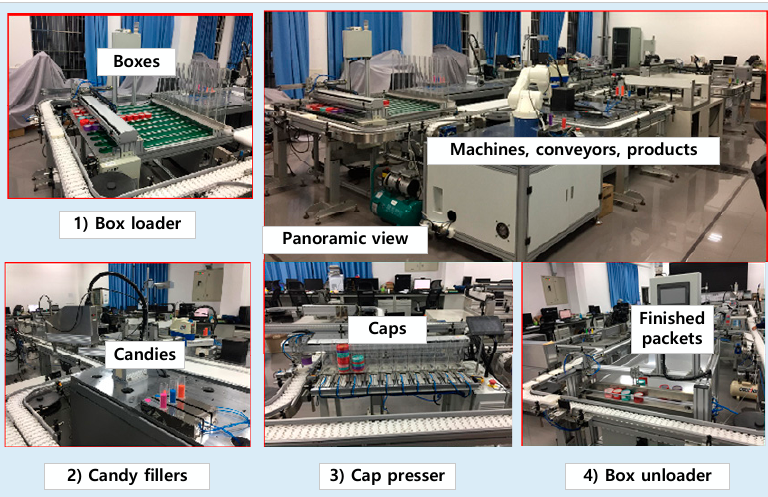
Figure 6. Snapshot of the smart factory called UniqueCandy.